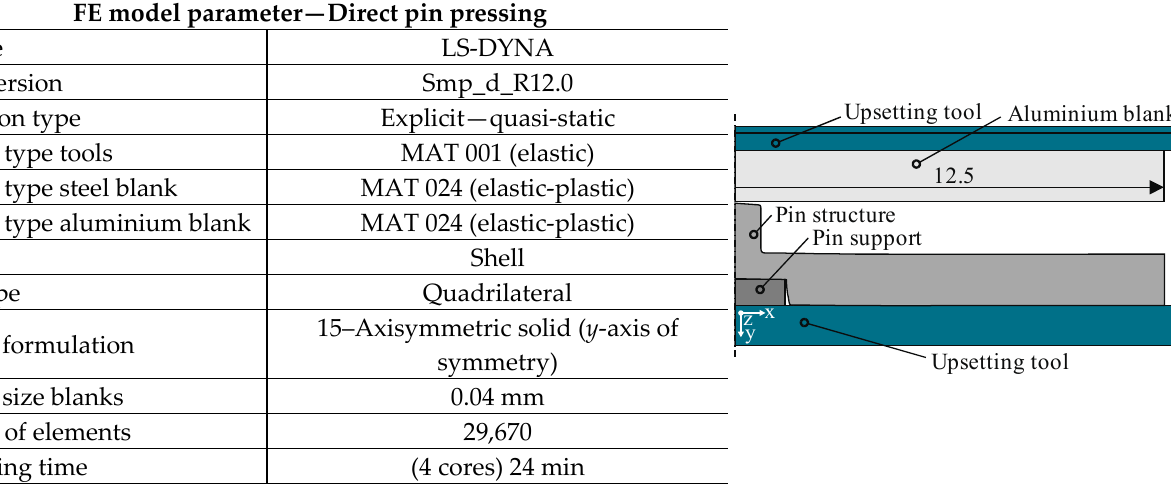
Figure 7. The relevant parameters of the FE-simulation of the direct pin pressing process as well as the FE-model design with the initial dimensions.